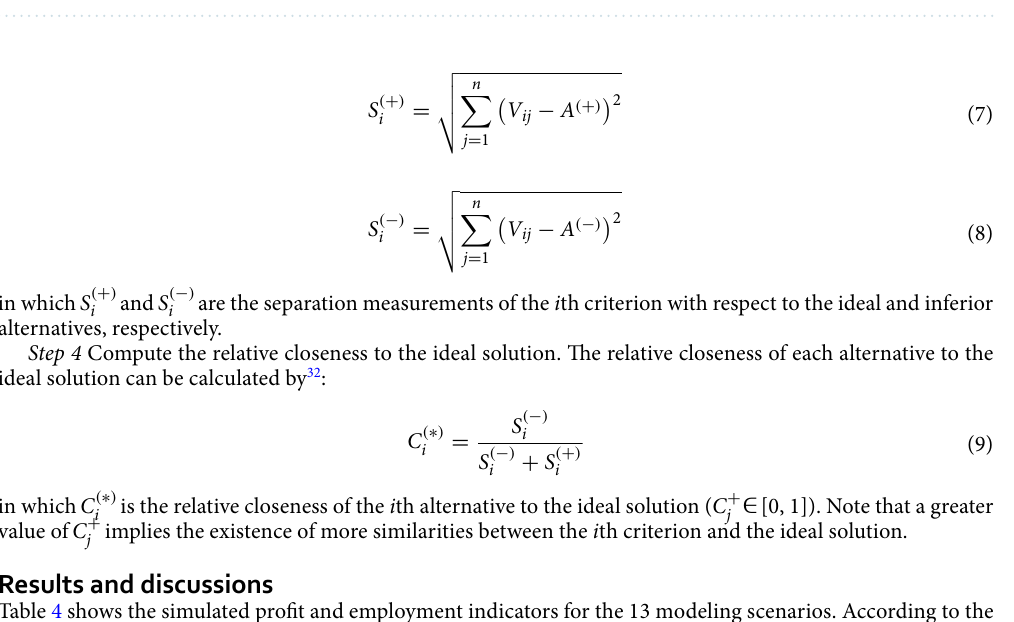
Table 4. Simulated profit index and employment index values for the 13